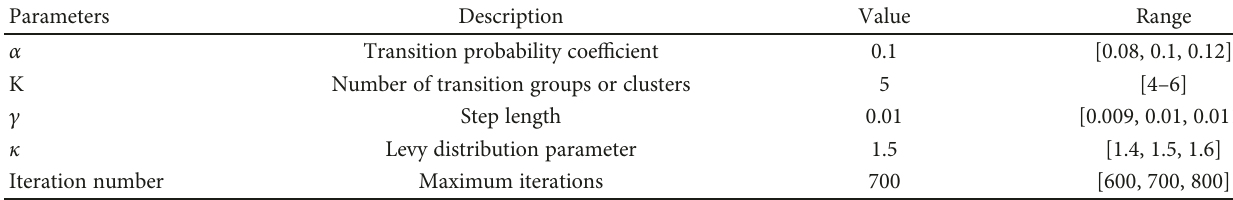
Table 2: Parameter setting for cuckoo search big data algorithm.